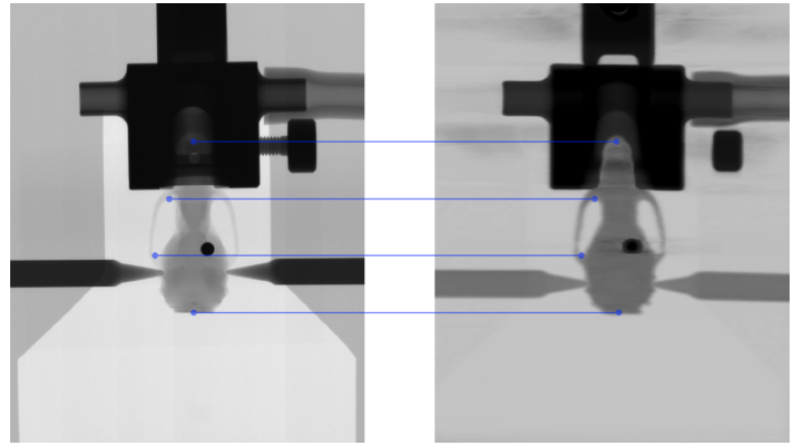
Figure 7. Images of rat skull phantom with embedded 3.2mm diameter ball bearing used for alignment. Planar X-ray radiograph from treatment room ( left ) and composite CT DRR ( right ). Blue markers indicate four of the corresponding alignment makers chosen in each image. For visual clarity of the figure, two markers on the RHS have been omitted.